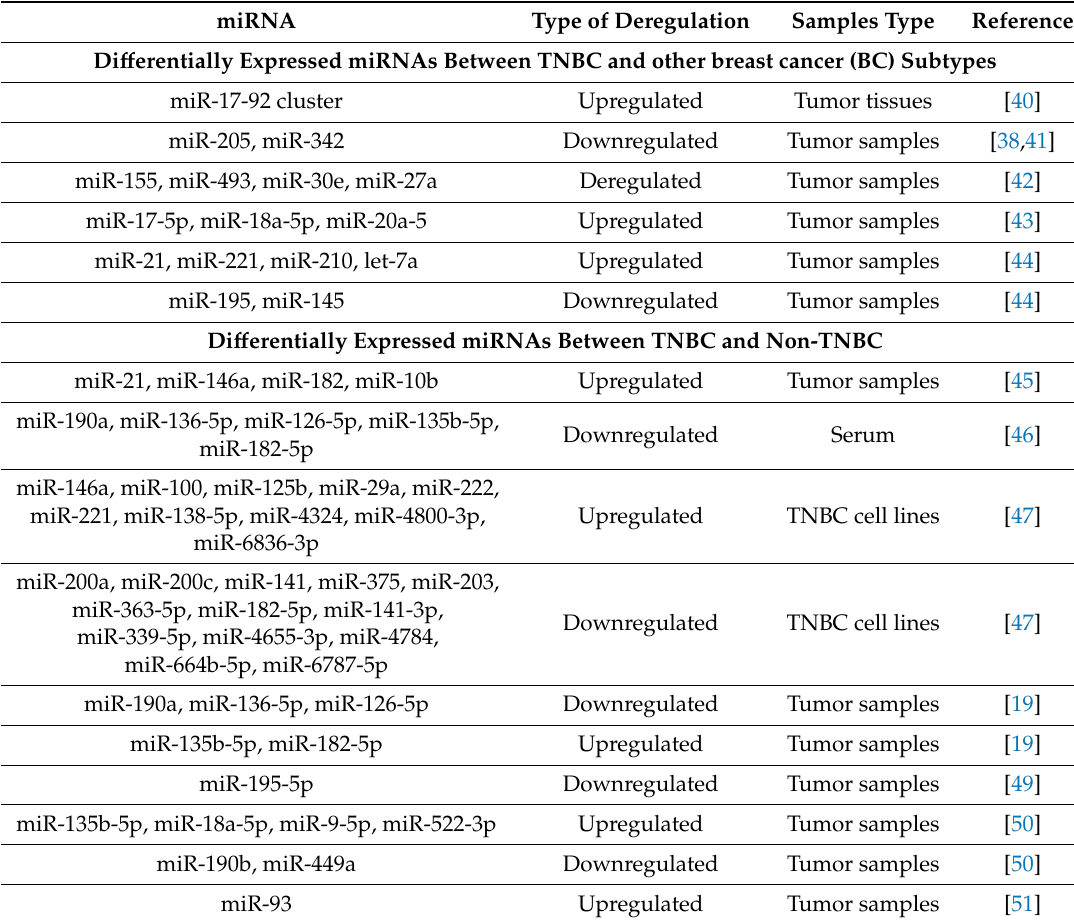
Table 1. The dysregulation of microRNAs in triple-negative breast cancer (TNBC).